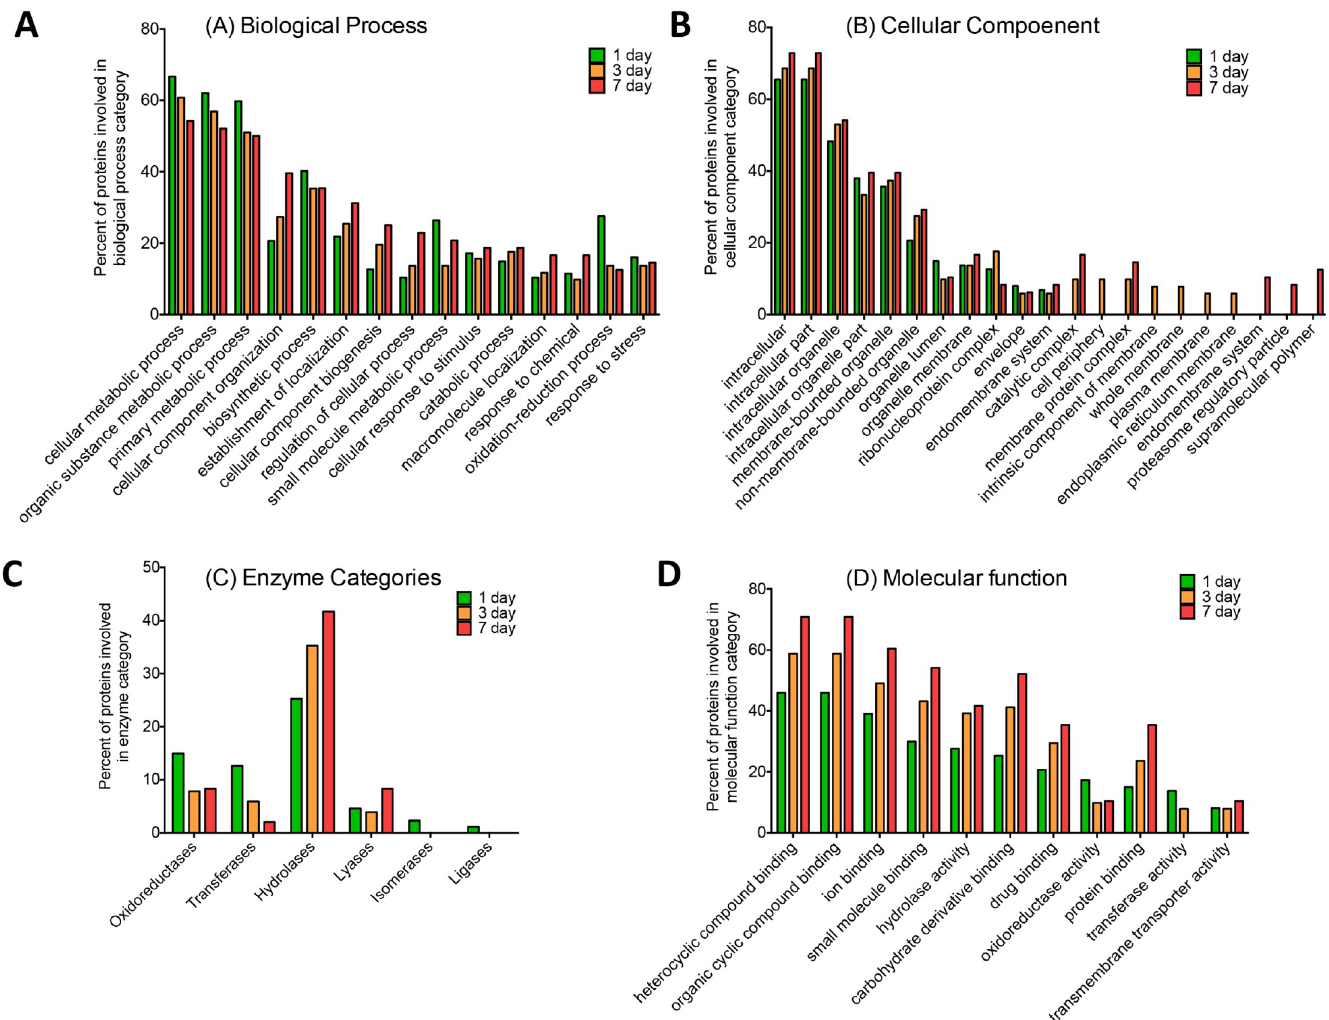
Fig 4. Bar chart showing changes in a number of proteins given various biological process (A), cellular component(B) [at level 3 ontology], enzyme categories (C) and molecular functions (D) on various time points. Proteins were assigned groups based on involvement in biological process, molecular functions and cellular component for the M . mycetomatis proteins identified within grain samples extracted from G . mellonella larvae during infection. Each group was assigned a percentage proportion of the total proteins found in the proteomic profile of each sample group.